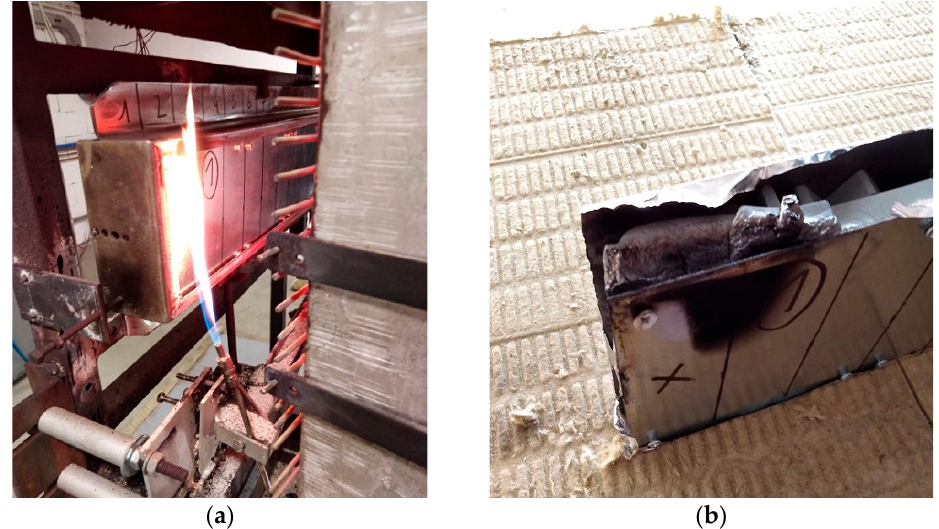
Figure 16. ( a ) Flame application on the second sample typology with the first layer in the metallic plate and ( b ) sample after the test.